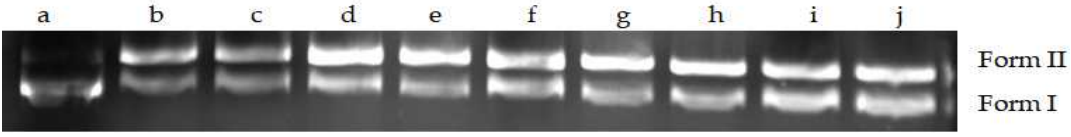
Figure 14. Effect of MA on topoisomerase II of S. aureus. Note: Form II (open circular DNA and linear); Form I (supercoiled DNA); a: pET-28a; b: topoisomerase; c: DMSO; d–j: 0.156 mg/mL; 0.3125 mg/mL; 0.625 mg/mL; 1.25 mg/mL; 2.5 mg/mL; 5 mg/mL; 10 mg/mL.